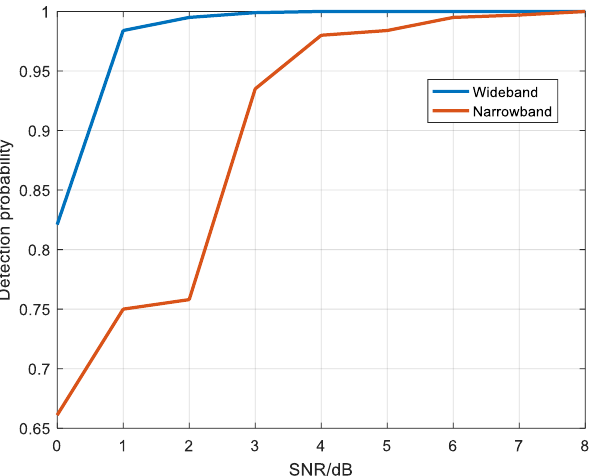
Figure 35. Detection probability diagram of wideband and narrowband under different SNR.